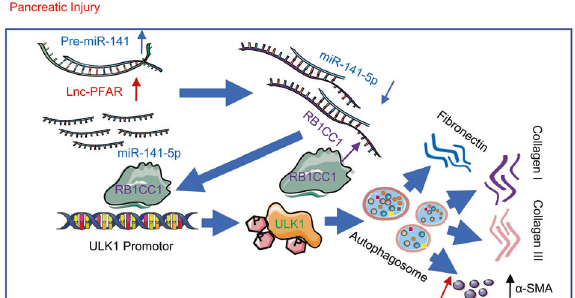
Fig. 7 Schematic presentation of the mechanism of Lnc-PFAR promoting pancreatic fi brosis development. Lnc-PFAR decreased the expression of miR-141 by inhibiting pre-miR-141 maturation, the reduction of miR-141-5P released RB1CC1, and then increased ULK1 expression. Eventually, the ULK1-induced autophagy aggravated PSCs activation and pancreatic fi